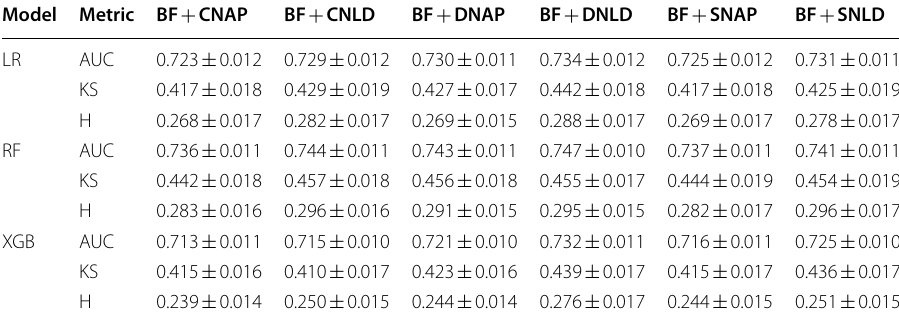
Each metric are measured in mean of 100 estimates obtained by repeating the outer ten-fold cross-validation procedure ten times (mean standard deviation from a 90% confidence interval) ± Table 30 Discrimination performance of different feature sets Model